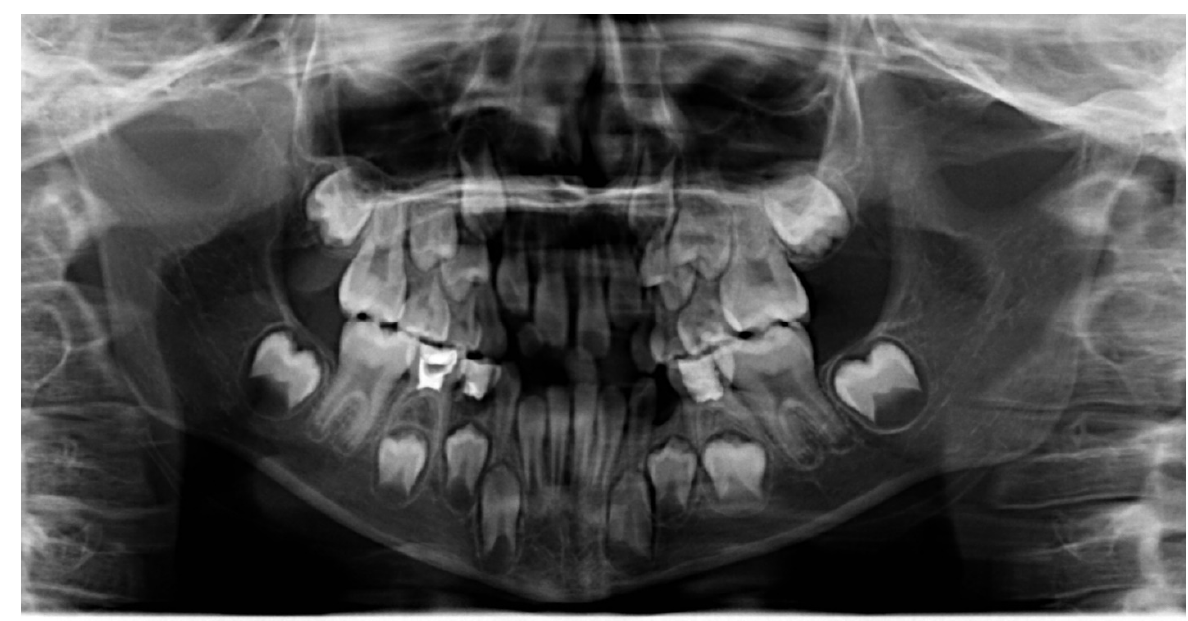
Figure 32. Radiographs of the patient at the screening. Orthopantomography X-ray before treatment (8-year-old).